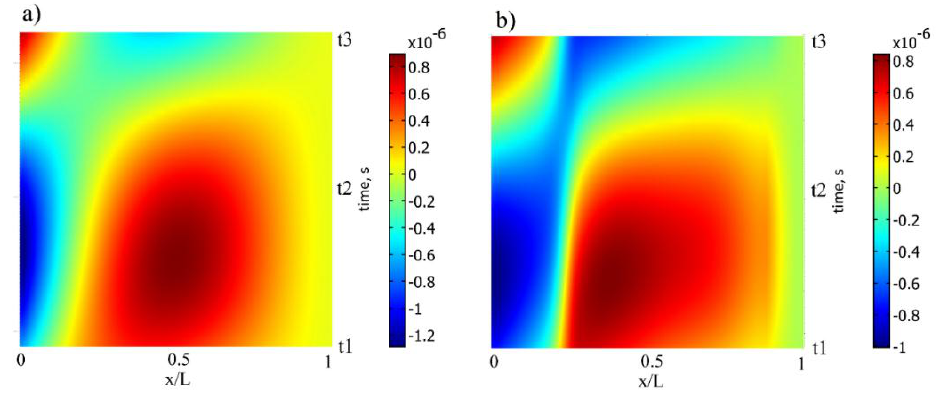
Figure 8. Normal strain distribution on the upper face of the cantilever in ½ T: ( a ) cantilever of a constant cross-section; ( b ) optimally-shaped cantilever.